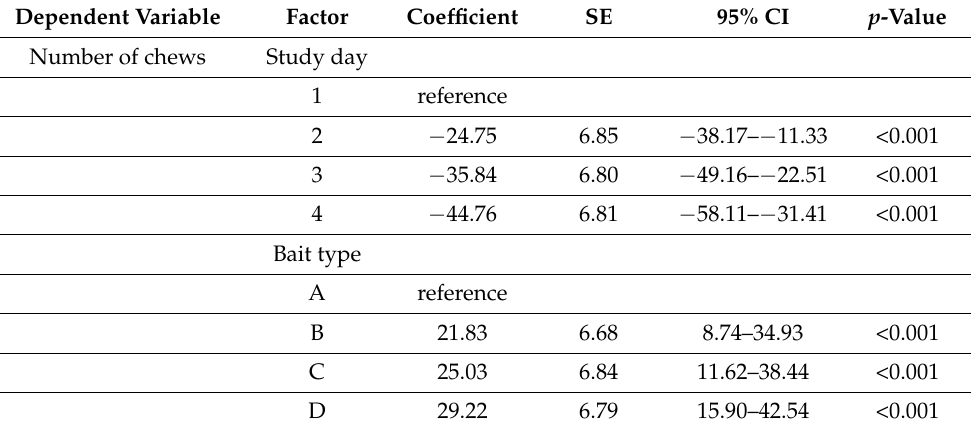
Table 5. Final linear mixed-effects model indicating factors associated with number of chews in